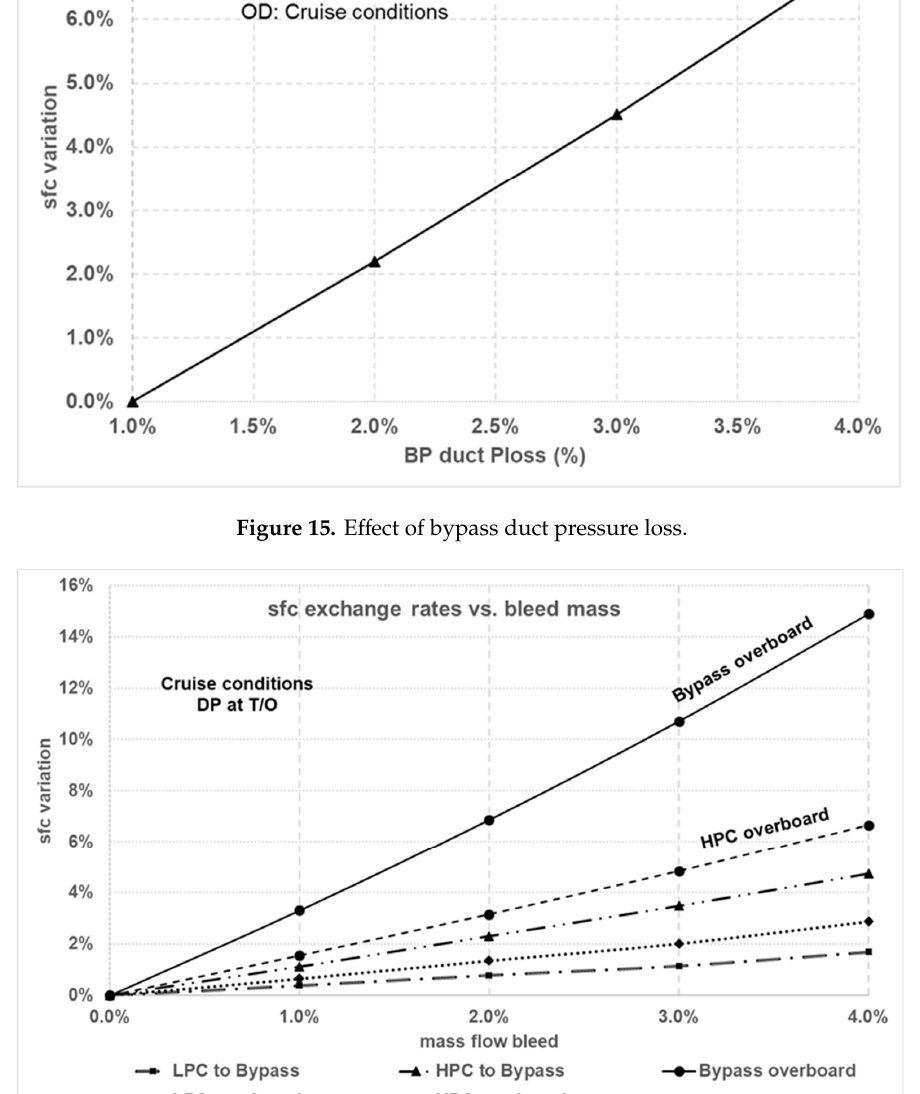
Figure 17. FN change vs. bleed mass. With regard to the added heat due to the utilization of AOHE and FOHE, it was shown that preheating the fuel offered a greater reduction to the SFC compared to the case in which the heat was directed to the bypass duct. The synthesis exchange rates showed a reduction of 1.32% for 150 kW added to the fuel before combustion (Figure 18). For the same amount of heat, the reduction was 0.38% in the case of AOHE.